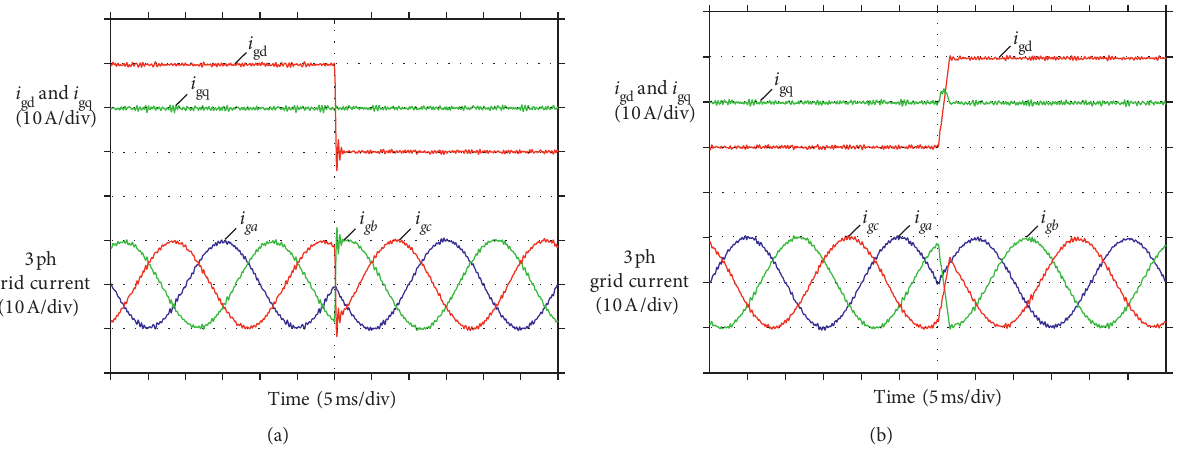
Figure 10: Simulation results of PCS in dynamic Process. (a) Waveforms of grid current both in dq and abc reference frame for transition from full load discharging to charging operation. (b) Waveforms of grid current both in dq and abc reference frame for transition from full load charging to discharging operation.